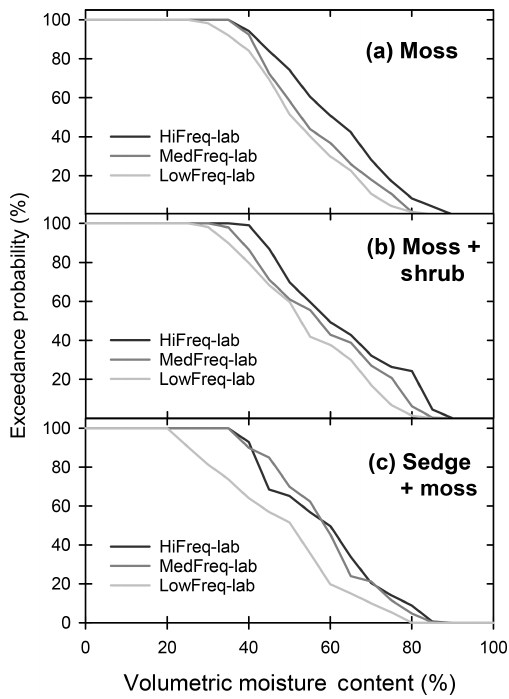
Figure 1. Exceedance probability of VMC from the (a) moss, (b) moss + shrub, and (c) sedge + moss peat monoliths subject to Hi-, Med-, and LowFreq-lab precipitation frequency treatments.